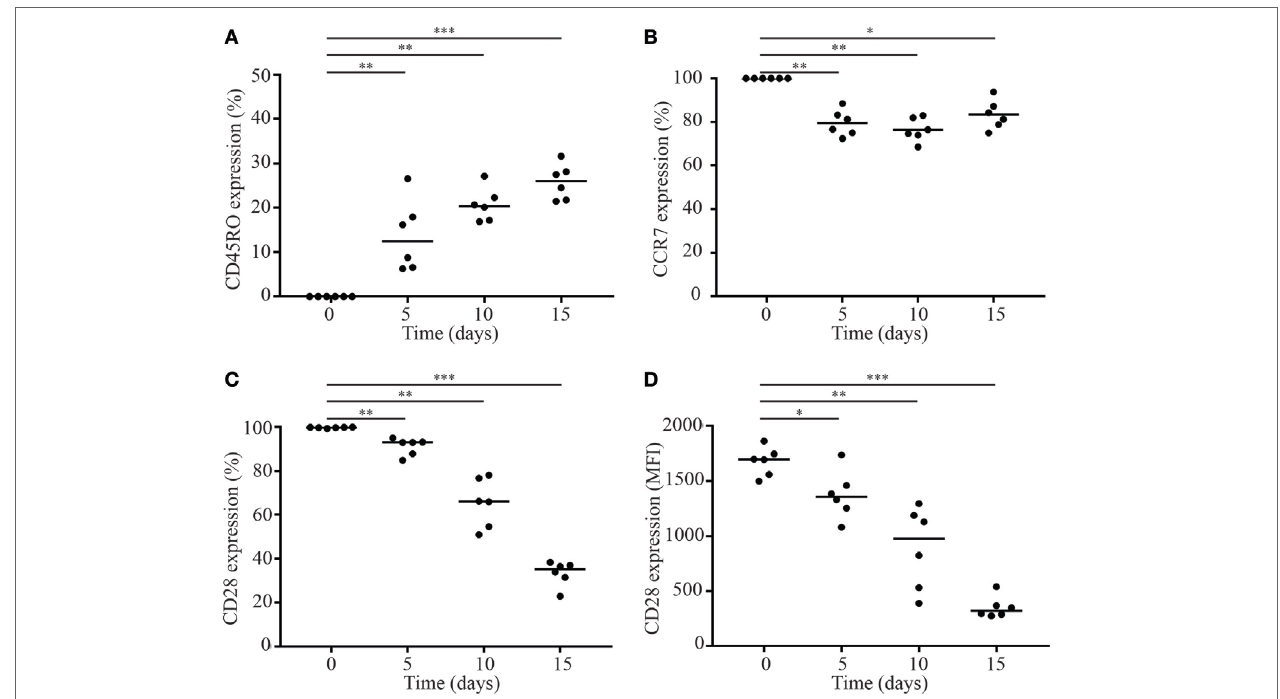
FigUre 3 | IL-15 induces loss of CD28 by naive CD8 + T cells. Fluorescence-activated cell sorting-sorted naive CD8 + CD45RO − CCR7 + CD28 + T cells were cultured in the presence of IL-15 (50 ng/ml). Directly after sorting and after 5, 10, and 15 days of culture, expression of (a) CD45RO, (B) CCR7, and (c,D) CD28 was assessed. MFI = median fluorescence intensity. Significance (* p < 0.05, ** p < 0.01, *** p < 0.001) is depicted. N =